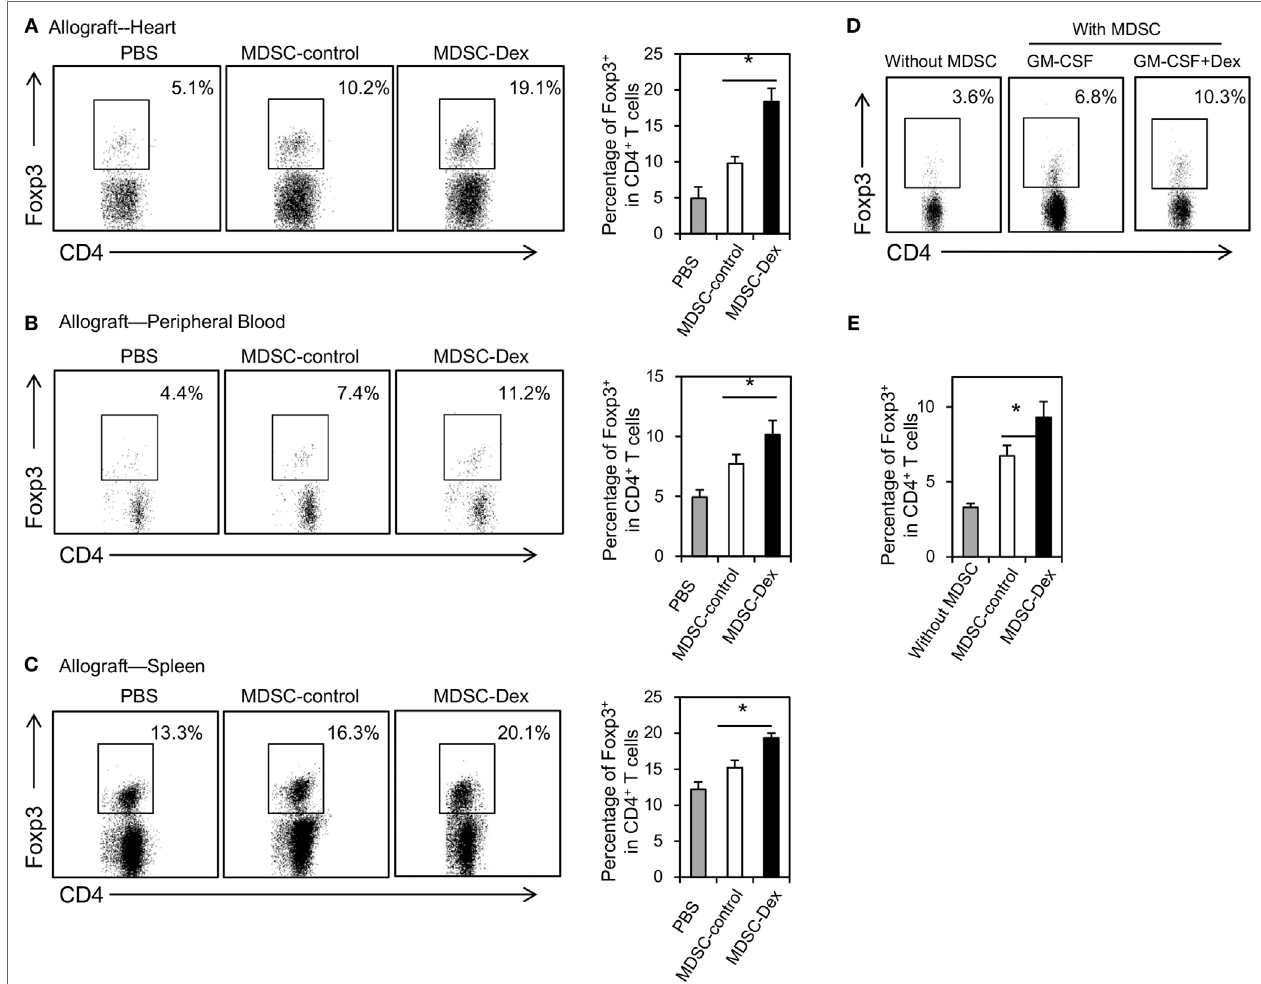
FigUre 5 | Adoptive transfer of myeloid-derived suppressor cells (MDSCs) induced by granulocyte macrophage colony stimulating factor (GM-CSF) and dexamethasone (Dex) favors the expansion of CD4 + Foxp3 + regulatory T cells (Treg) in vivo . MDSCs induced by GM-CSF or GM-CSF + Dex (3 × 10 6 per mice) were adoptively transferred into recipient mice via the tail vein immediately after cardiac allograft transplantation. On post transplantation day 7, recipient mice were euthanized and the percentages of CD4 + Foxp3 + Treg in allograft (a) , peripheral blood (B) , and spleen (c) were assessed. (D,e) MDSCs (CD45.2, C57BL6/J) induced by GM-CSF or GM-CSF + Dex mice were cocultured with CD4 + T cells (CD45.2, C57BL6/J) purified by flow cytometry from the spleen at a ratio of 1:4 in the presence of anti-CD3 (5 μ g/ml)/CD28(2 µg/ml) for 3 days. The percentages of Foxp3 + cells in CD4 + T cells were assessed. Data are Mean ± SEM. All the data are composite of three independent experiments ( n = 3–5 in each group). P values were determined by Student’s t -test. * P < 0.05, N.S., not